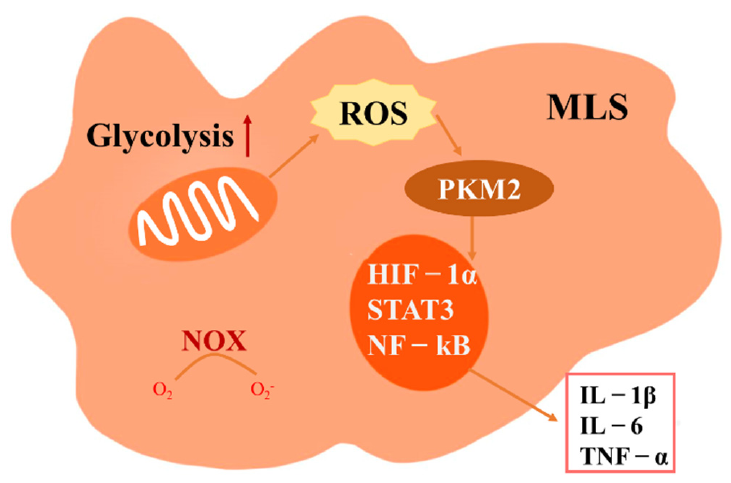
Figure 3. The role of ROS in macrophage-like synovial cells (MLSs). Under conditions, such as the inflammation and hypoxia that occur in RA joints, the MLSs switch to a high-load glycolytic metabolism, resulting in ROS leaking from the electron transport chain and the activation of pyruvate kinase M2 (PKM2), which in turn activates key downstream transcription factors, such as STAT3, NF-KB and hypoxia-inducible factor-1 α (HIF-1 α ), to drive TNF- α , IL-1 β and IL-6 production. ROS are known to maintain the homeostasis of macrophages, especially during macrophage polarization [85,94]. M1 and M2 macrophages have also been character- ized as oxidative and reducing macrophages based on intracellular glutathione content